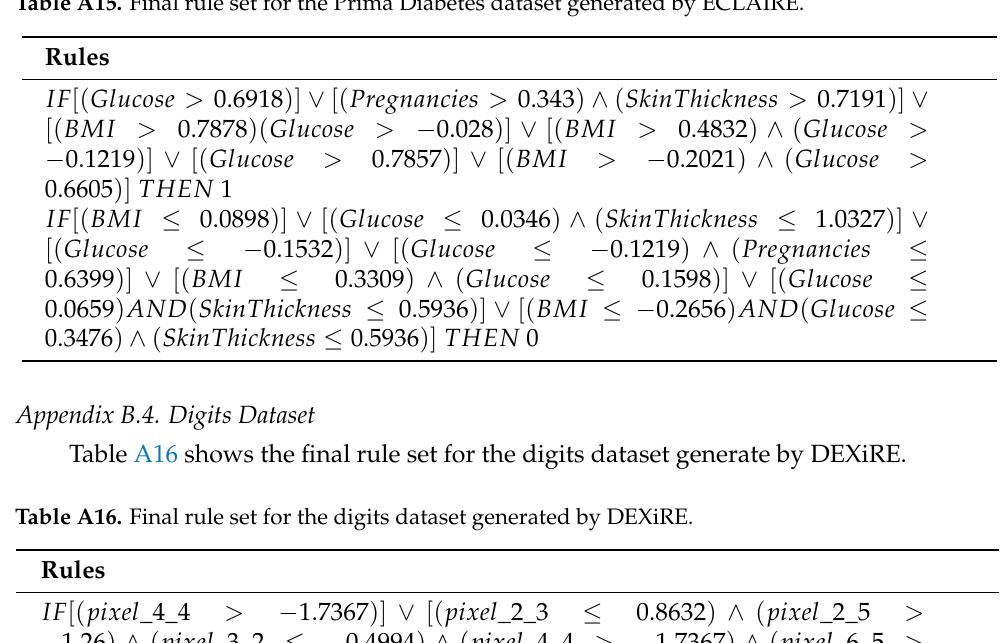
Table A15. Final rule set for the Prima Diabetes dataset generated by ECLAIRE.